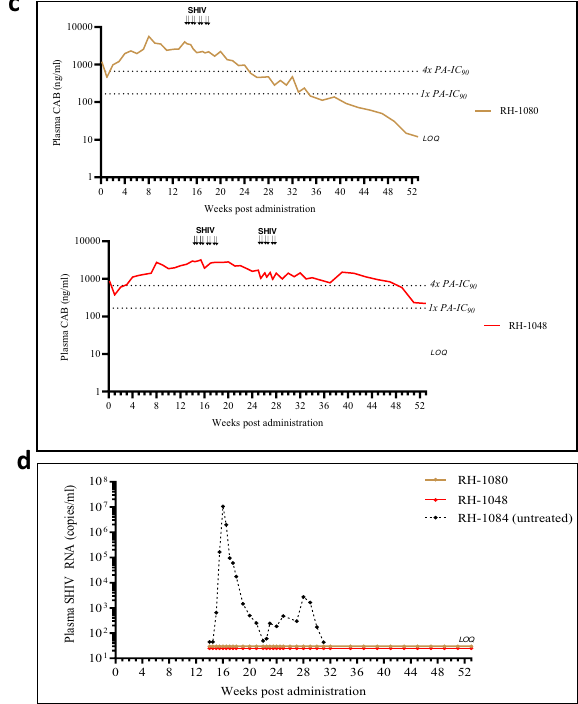
Fig. 5 | Ef fi cacy of CAB ISFI against rectal SHIV infection in rhesus macaques. a Short-termprotectionbyCABISFIs.TwoCABtreated(RH-1093andRH-1097)and one untreated macaque (RH-1092)wereexposedrectally to SHIV betweenweeks 4 and 8 post implantation. Each animal received rectal SHIV challenges twice per week for up to 4 weeks(totalof eight exposures).Arrowsindicate SHIV exposures. ISFIs were surgically removed at week 12 (blue and purple solid circles) b Plasma SHIV RNA levelsdetected by real-time PCR in animals during challenge period and